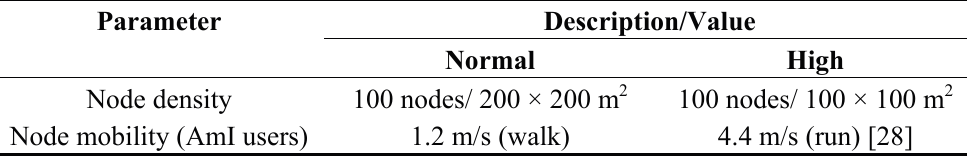
Table 7. Node density and mobility parameter settings of protocol set